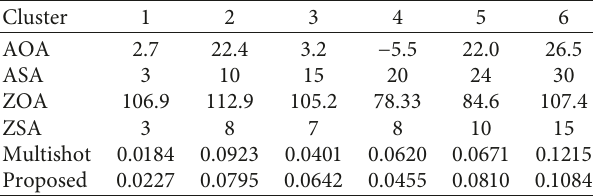
Table 3: RMSD results under single-cluster cases.